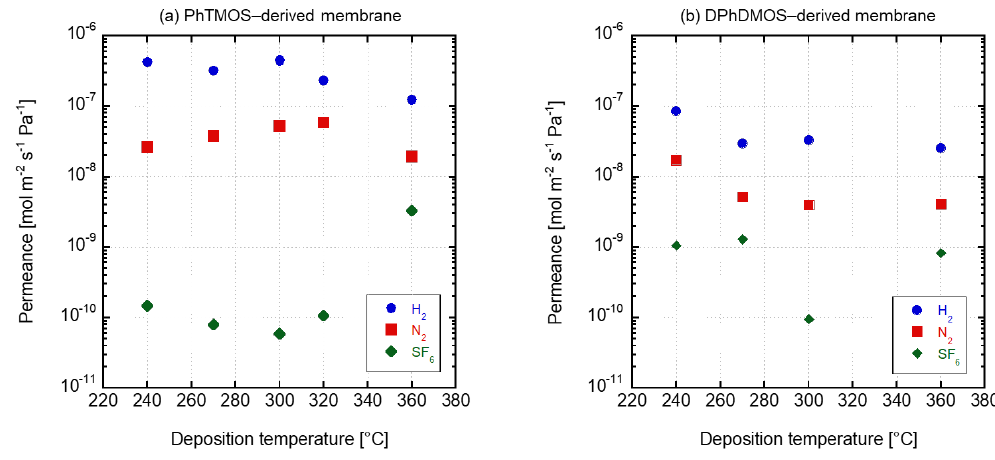
Figure 4. The gas permeation performance of ( a ) PhTMOS-derived and ( b ) DPhDMOS-derived membranes.